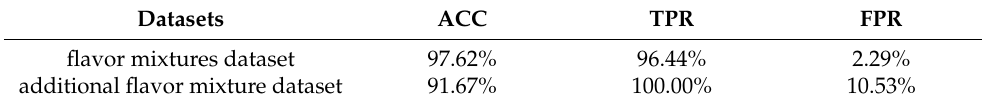
Table 2. The results of the pSCNN model on the experimental NMR